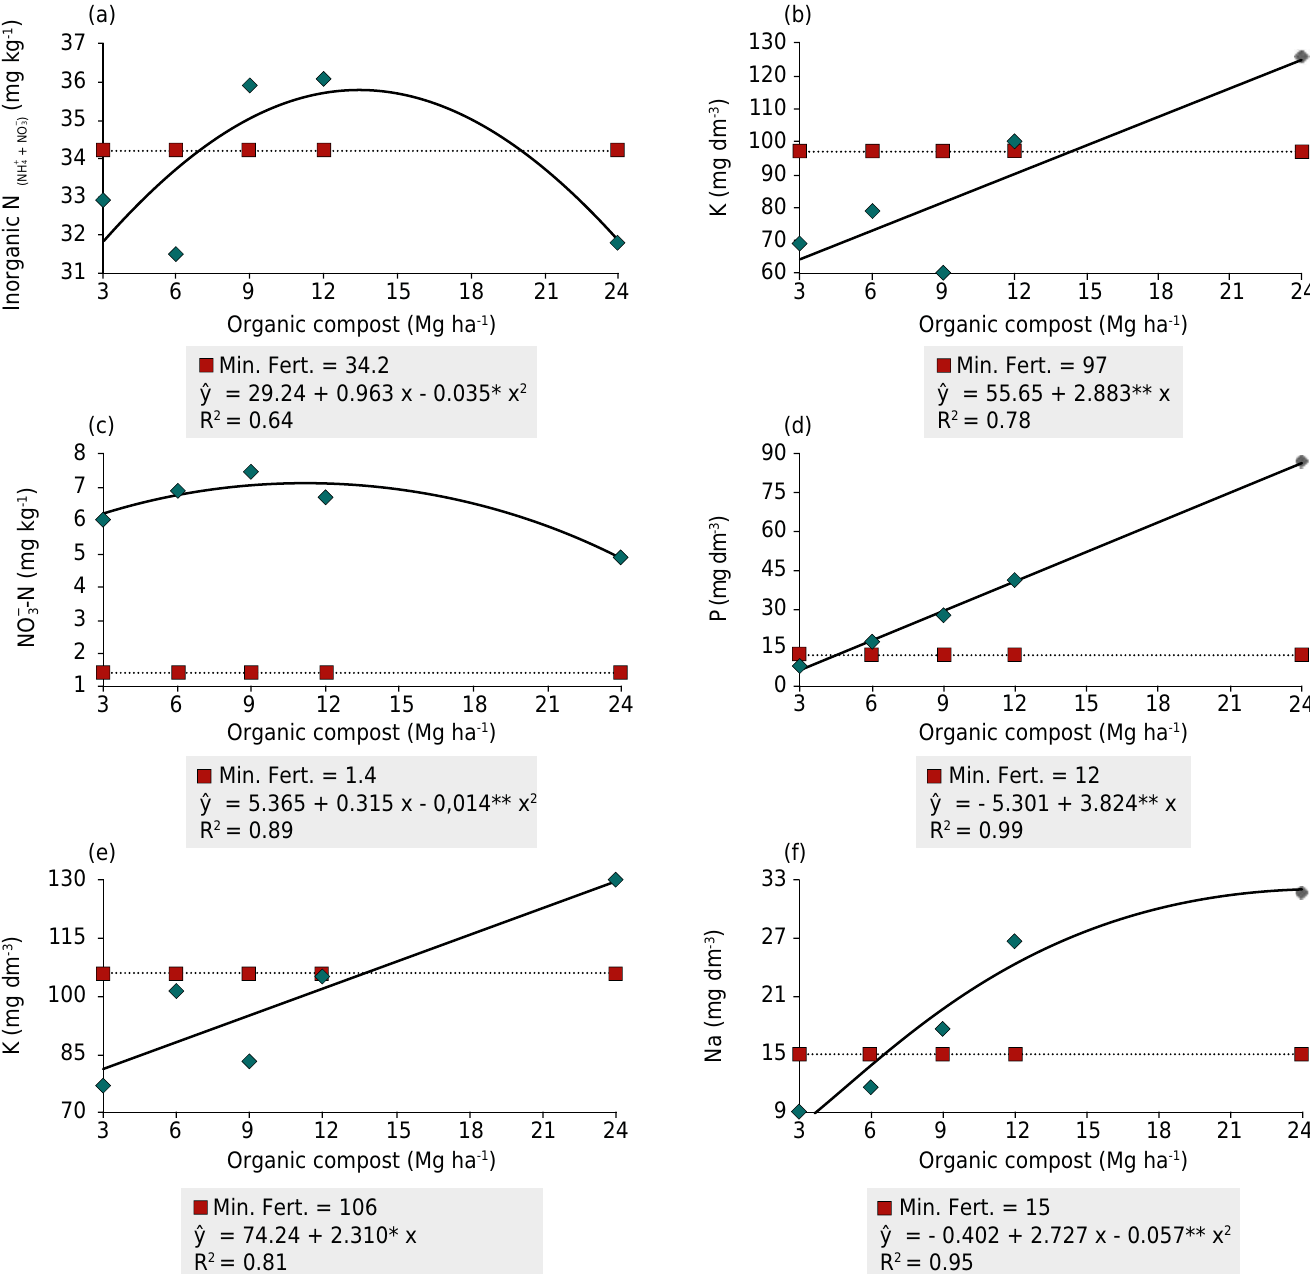
Figure 2. Concentration of inorganic nitrogen (a) and potassium (b) for the 2013 crop; concentration of nitrate (c), phosphorus (d), potassium (e), and sodium (f) for the 2014 crop, in the soil surface layer (0.00-0.20 m) as a function of application rates of organic compost. * and ** : significant at 5 and 1 % probability, respectively. Min. Fert.: Mineral